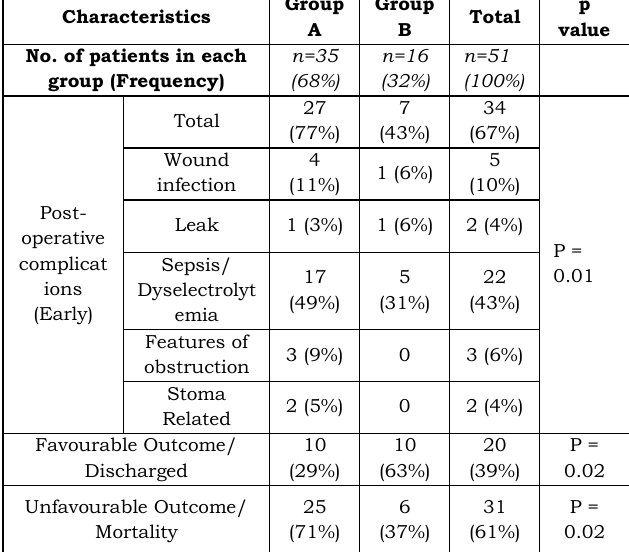
Table 6: Comparative details of complications and outcomes of two study groups [p<0.05 is considered significant]. Characteristics